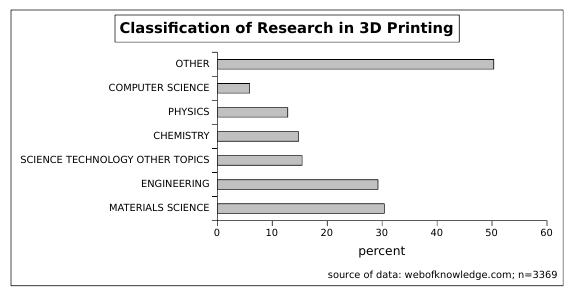
Figure 4. Classification of articles for 3D Printing; source of data: webofknowledge.com.